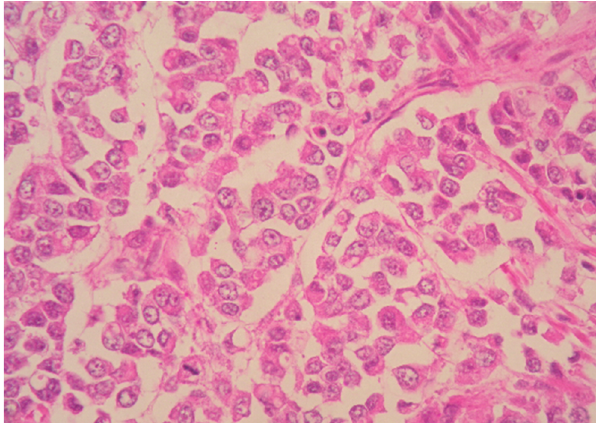
Figure 5 - Anal melanoma. Cross-section of the tumor region (H&E 6